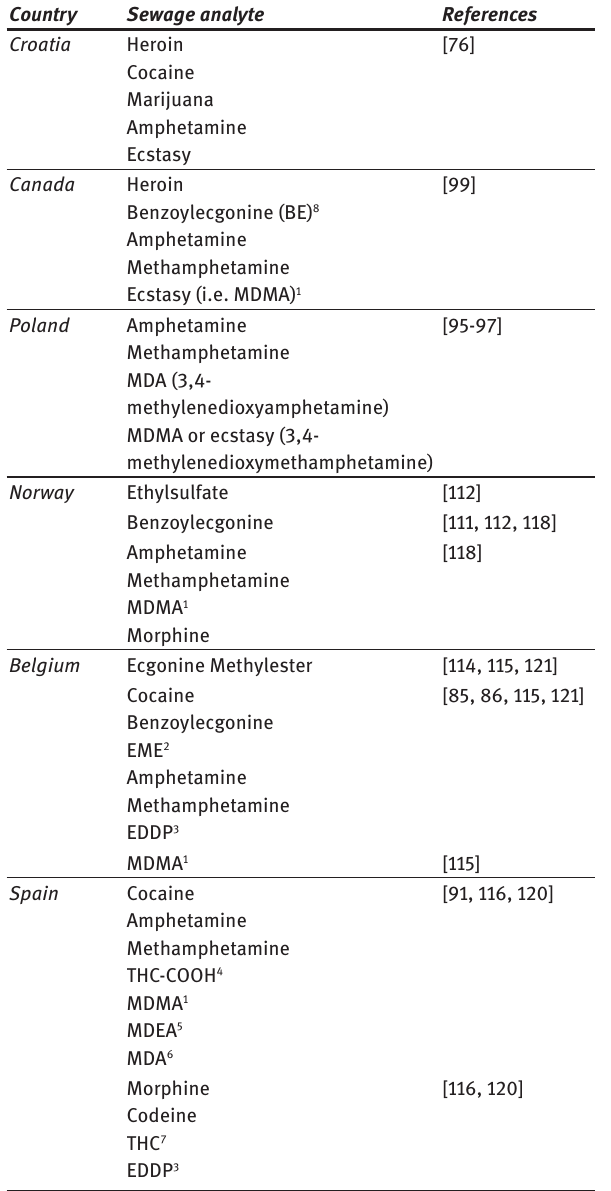
Table 1: The analysis of community-wide drug consumption by detection and quantification of specific urinary excretion products in